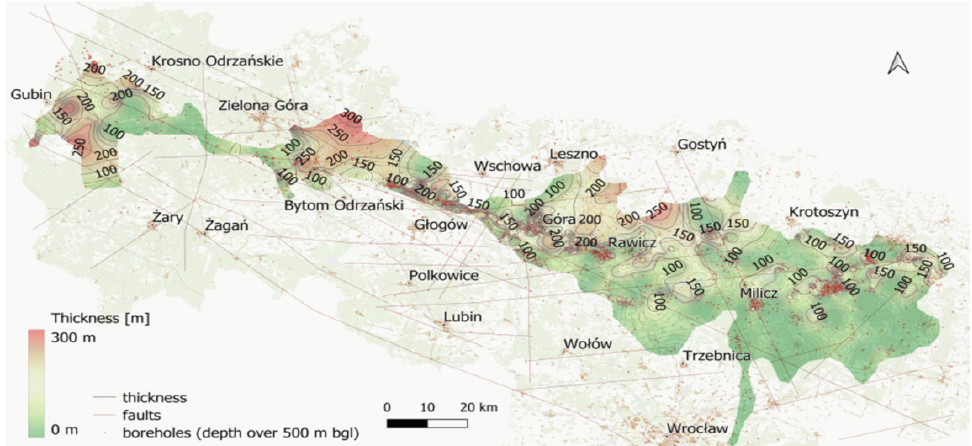
Figure A3. The thickness map of the oldest rock salt (Na1) layer occurring to a depth of 1800 m bgl.